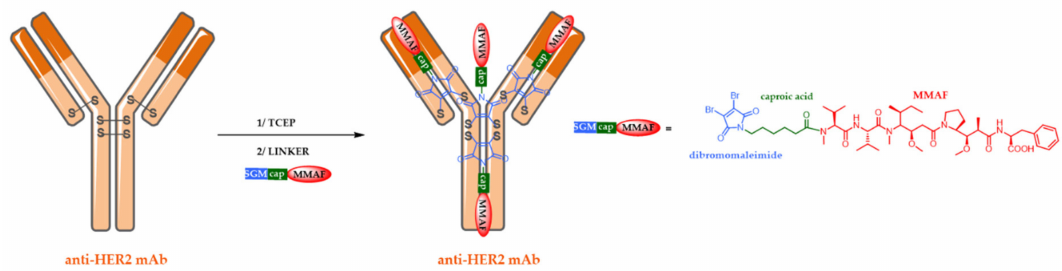
Figure 4. Homogeneous ADC with a DAR 4 obtained by complete reduction (TCEP) of all 4 interchain disulfide bridges followed by a site-specific bioconjugation reaction via a dibromomaleimide linker